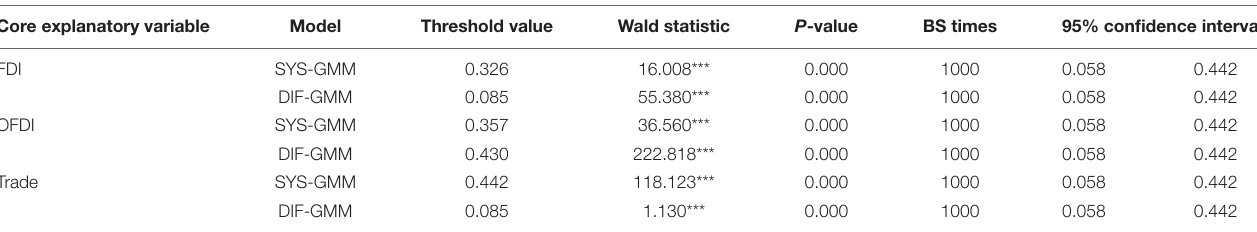
TABLE 6 | Self-sampling test of a dynamic threshold